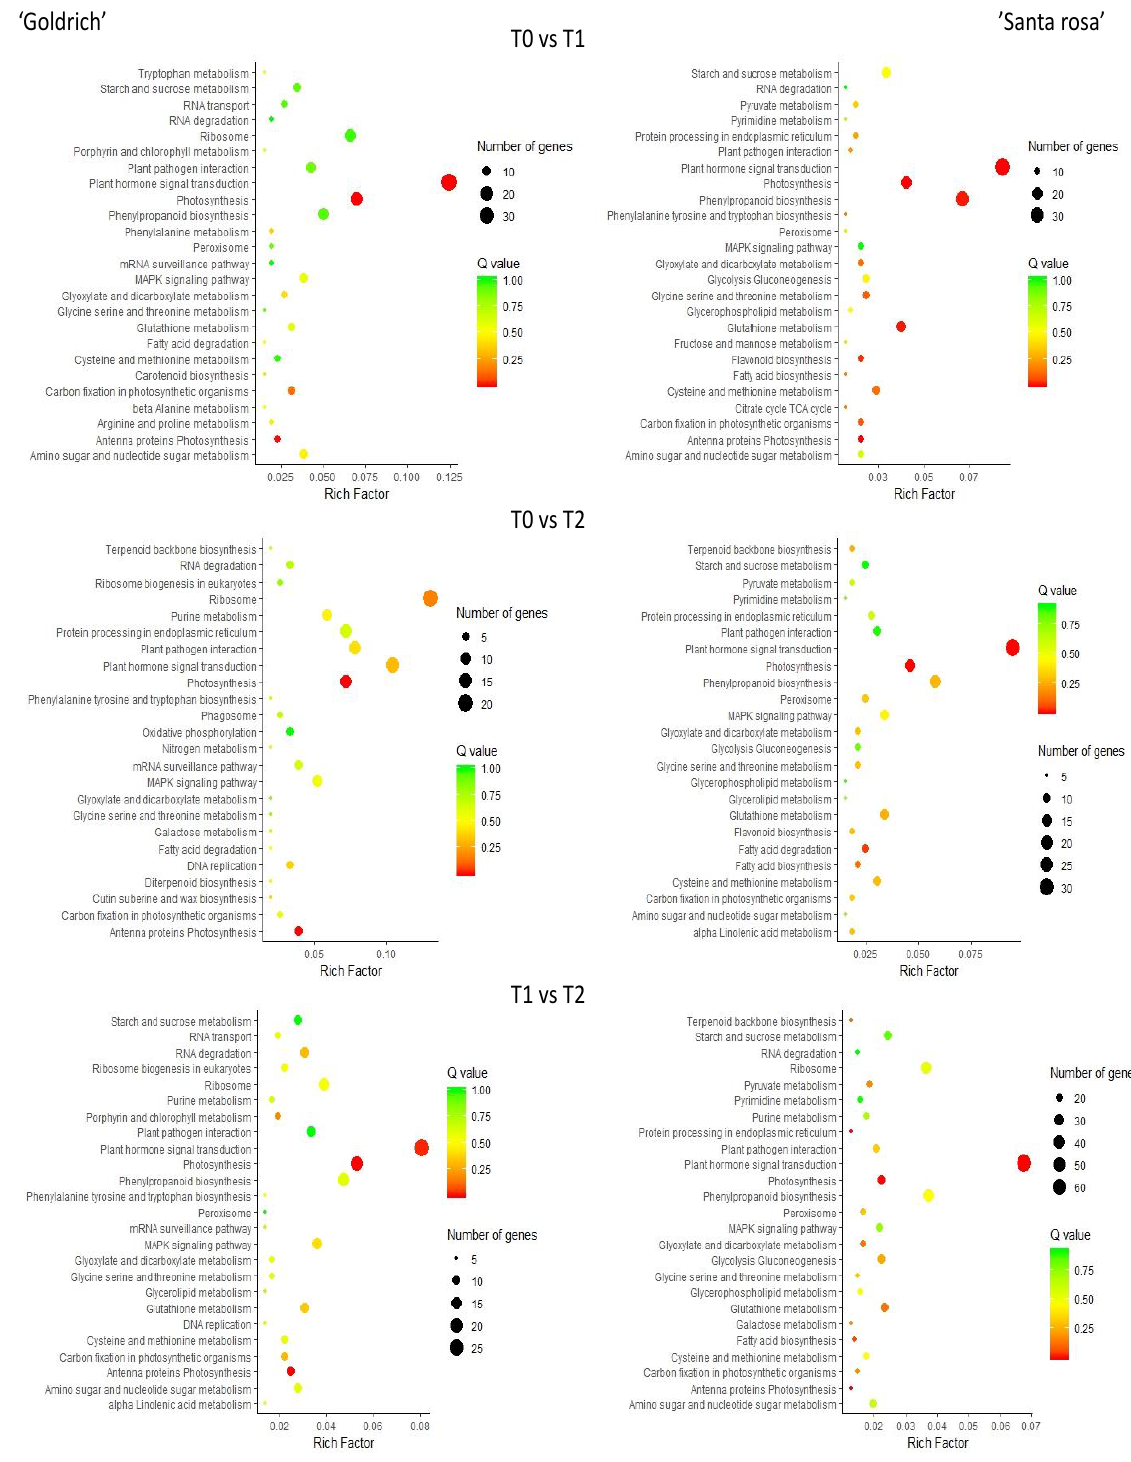
Figure 4. Metabolic pathway analysis based on DEGs filtering ( − 1 > log2FC > 1; p -value < 0.005) for T0 vs. T1, T0 vs. T2, and T1 vs. T2 comparison in apricot ‘Goldrich’ and Japanese plum ‘Santa Rosa’. Advanced bubble chart shows enrichment of DEGs to each signaling pathway. The Y -axis label represents the pathway, and the X -axis label represents the rich factor. The size and color of the bubble represent the amount of DEGs enriched in pathway and enrichment significance, respectively.